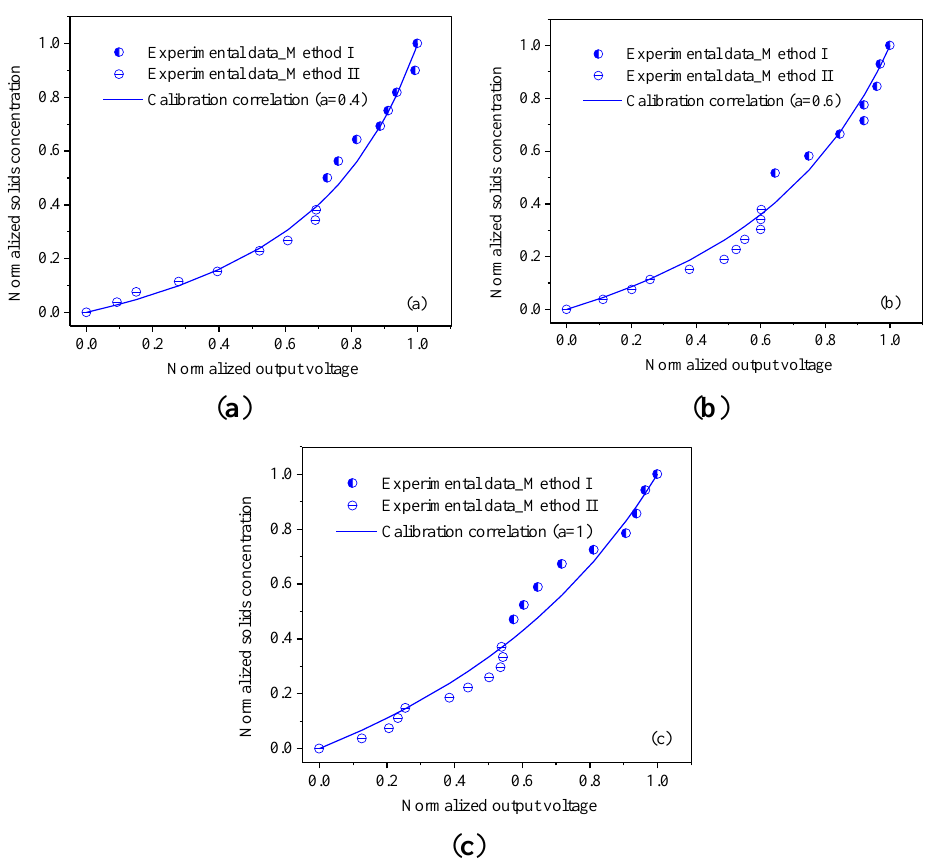
Figure 7. Calibration curves for Glass beads: ( a ) GB 1#; ( b ) GB 2#; ( c ) GB